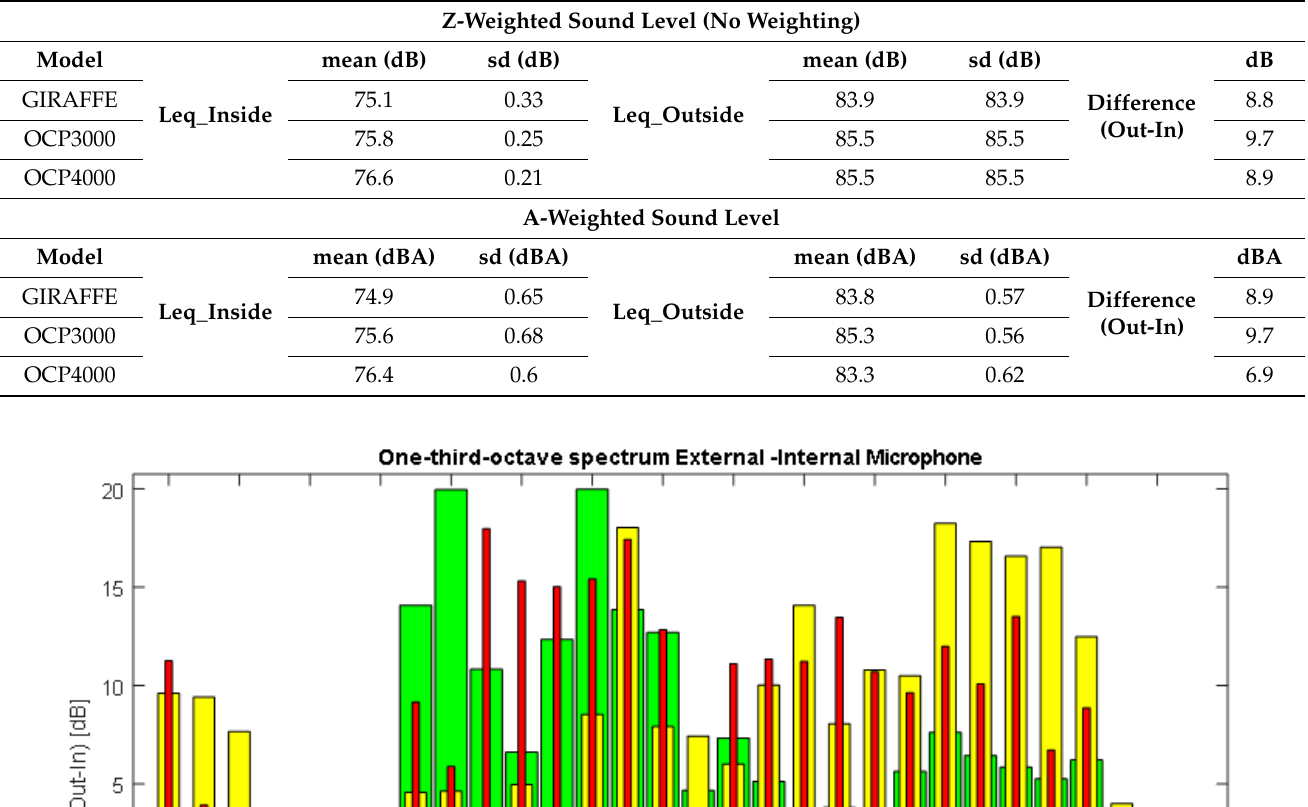
Protection Value (f) = Mean - STDev